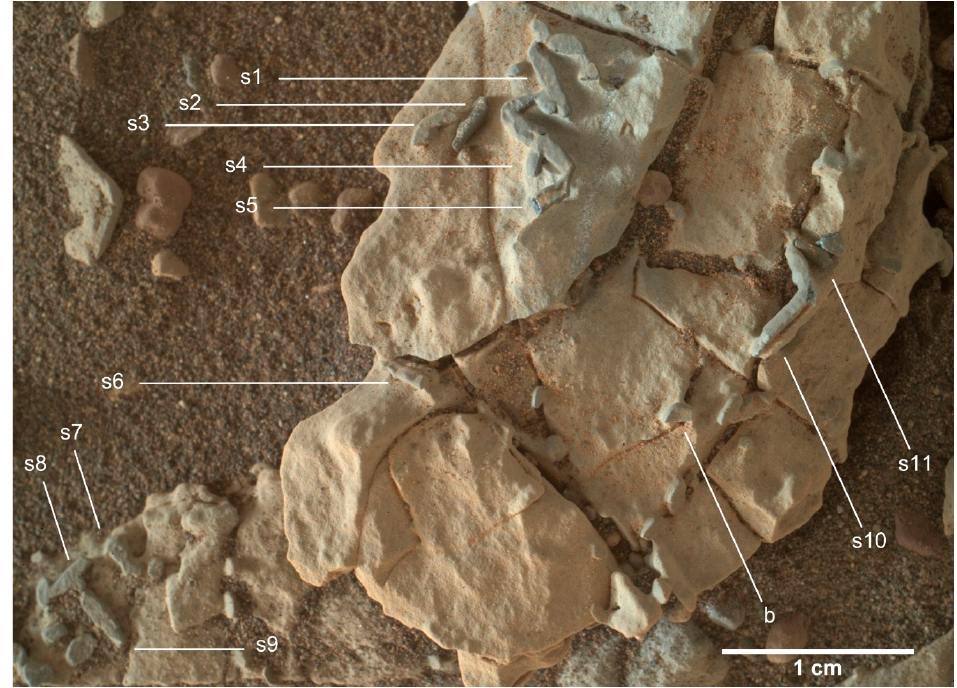
Figure 1. The stick ‐ like structures at Vera Rubin Ridge, Mars. Labels indicate individual specimens of stick ‐ like structures (s1 ‐ s11) and bulbous structures (b). Outcrop imaged by rover Curiosity using